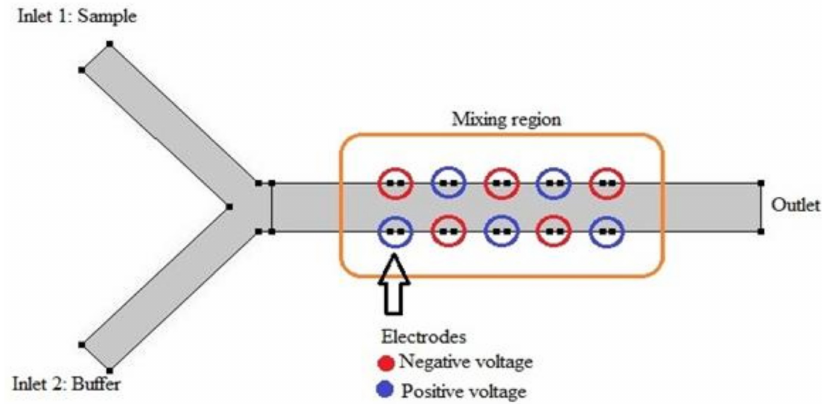
Figure 3. Mixer subunit; the main channel is 9 mm long and is 1 mm wide. As the flow passes the passage, it experiences alternating voltage executed by 10 electrodes which are positioned in zigzag configuration. The slip velocity plays a key role in mixing two parallel